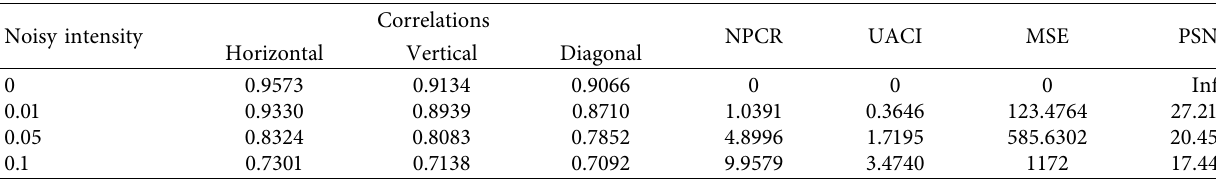
Figure 8: The cipher images and the corresponding decrypted images under noise attack. (a) Cipher image under 0.01 noise intensity. (b) Cipher image under 0.05 noise intensity. (c) Cipher image under 0.1 noise intensity. (d) Decrypted image under 0.01 noise intensity. (e) Decrypted image under 0.05 noise intensity. (f) Decrypted image under 0.1 noise intensity. Table 9: The resistance ability to noise attack of this